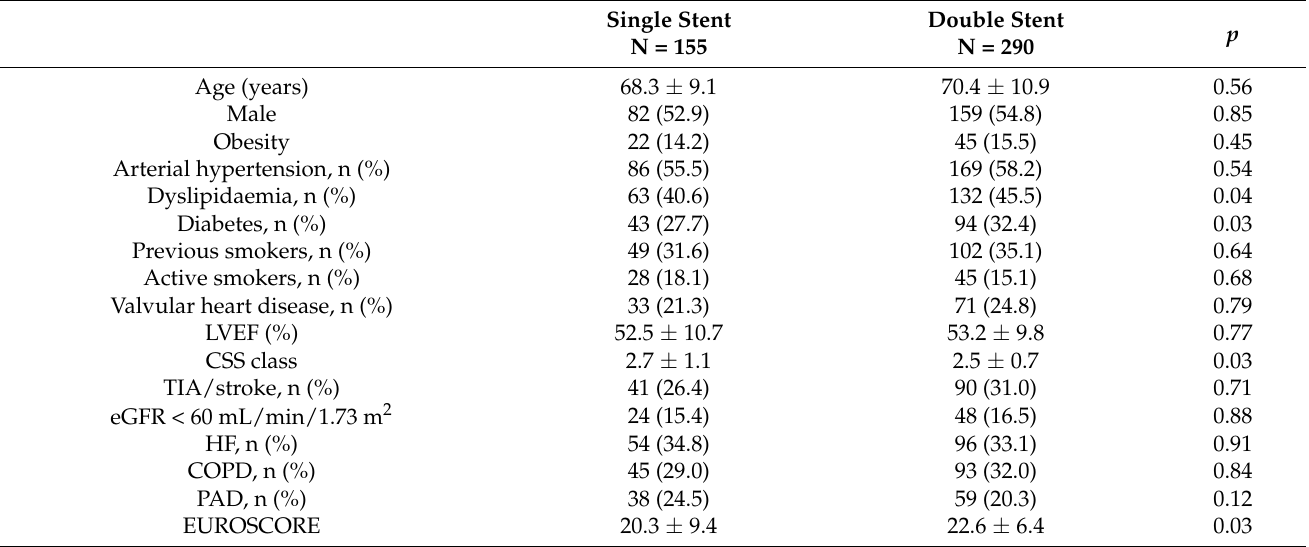
Table 1. Demographic and clinical characteristics of the analysed cohorts of patients’ single versus double stent